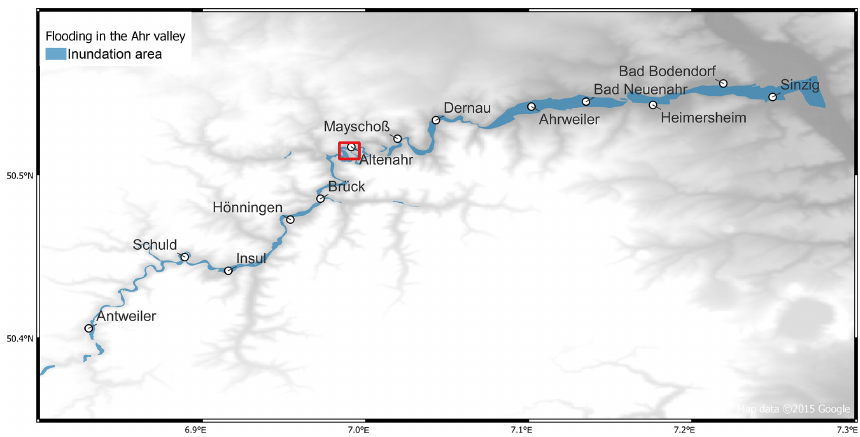
Figure 10. Overview of the inundation area along the river Ahr between Antweiler and the mouth into the Rhine at the time of largest extent (blue), based on various sources including private drone footage, photos from social media, and satellite imagery (as of 18 July 2021). The red box indicates the area shown in Fig. 11 (© Google Earth).